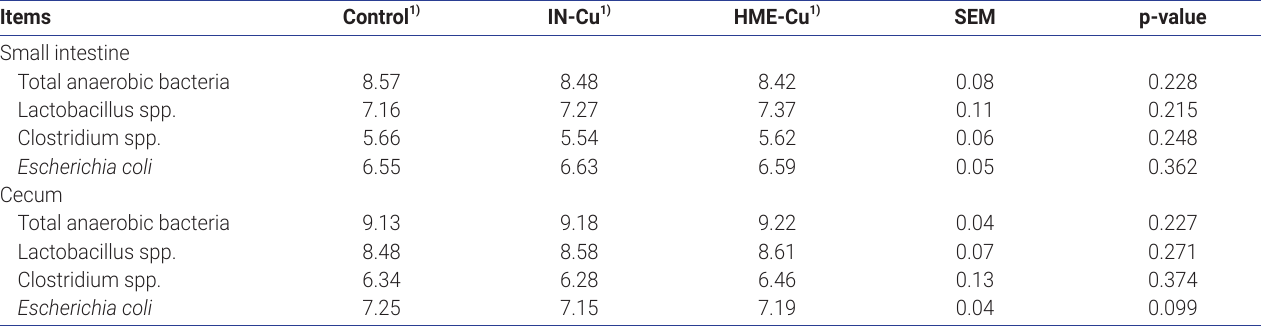
Table 5. Effect of dietary Cu concentrations and sources on gut microbiota in broilers